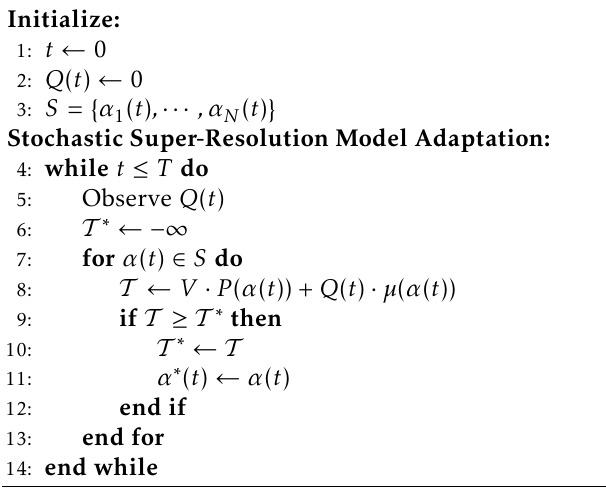
Algorithm 1 Proposed Super-Resolution Deep Learning